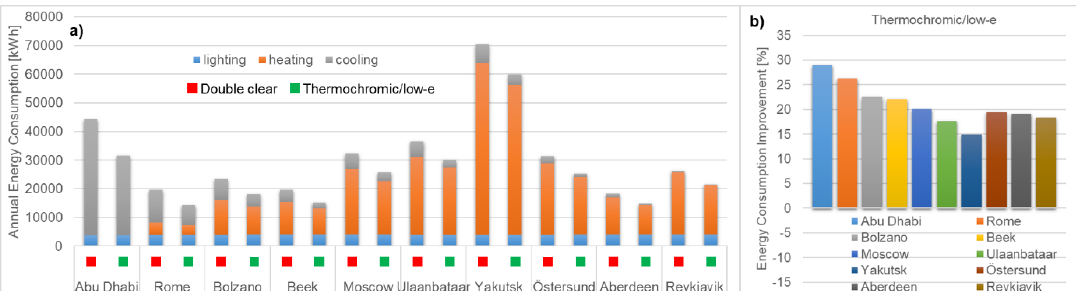
Figure 10. ( a ) Annual energy consumption due to lighting, heating and cooling of a residential building equipped with double clear or thermochromic / low-e glazing at various locations; ( b ) annual energy consumption improvement of thermochromic / low-e glazing in comparison to clear glass for various